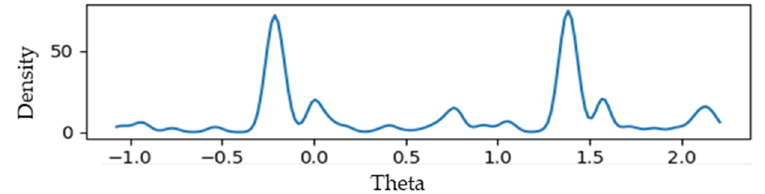
Figure 6. Kernel density estimation (KDE) of the line angles.